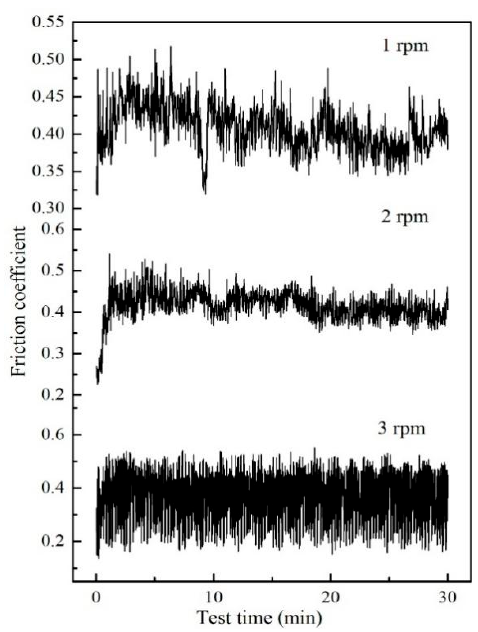
Figure 7. Time dependencies of the friction coefficient of Mo-Ti-Al-N coatings fabricated at 1, 2, and 3 rpm.